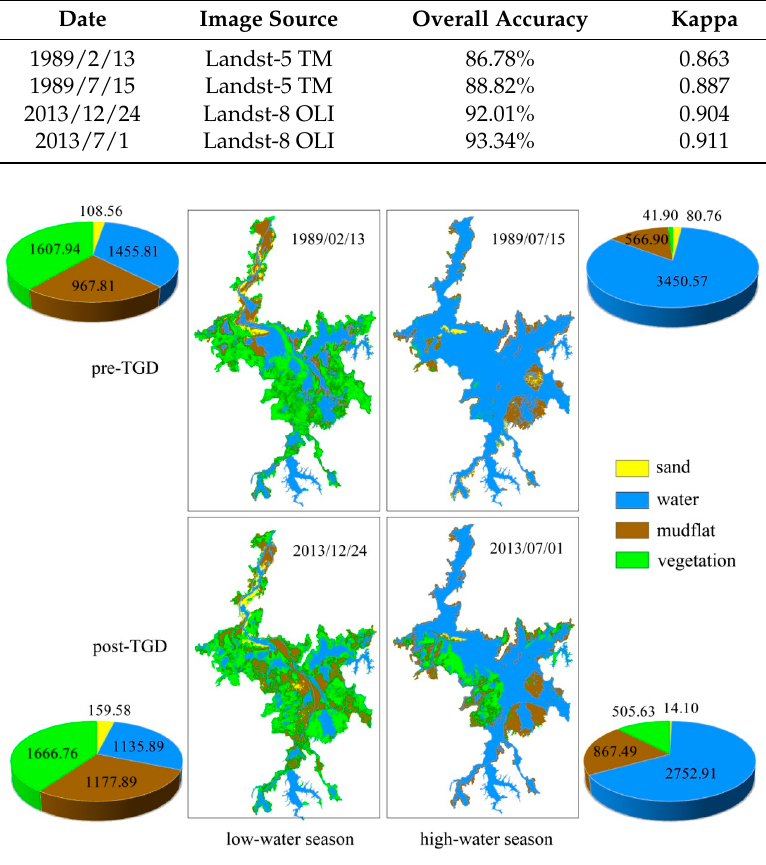
Figure 4. Land cover/land use maps during different periods produced by image classification.